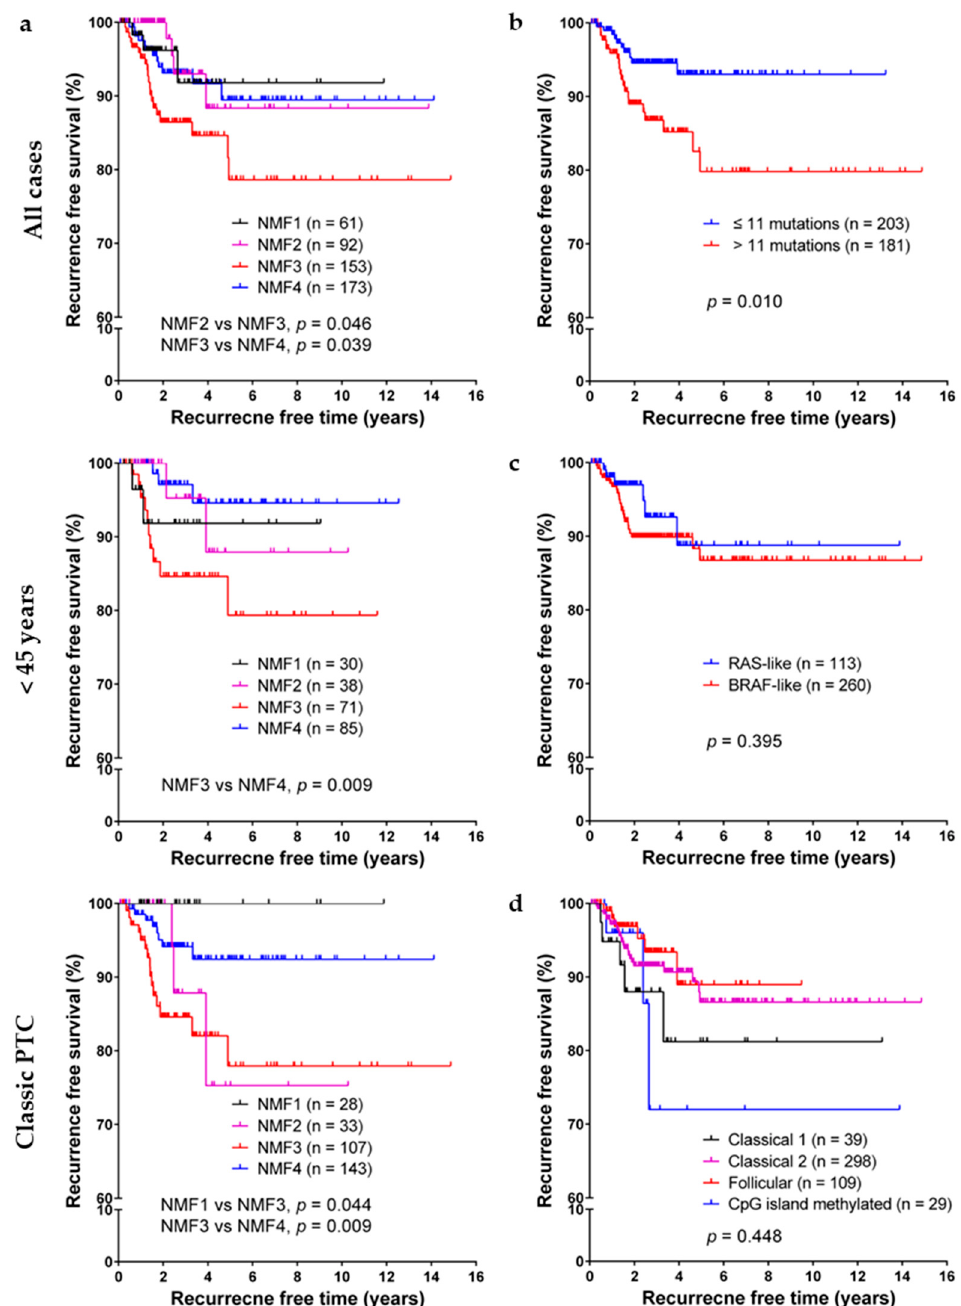
Figure 4. Survival analysis. ( a ) Kaplan–Meier survival curves of papillary thyroid carcinoma (PTC) patients on disease recurrence free survival stratified according to the four NMF clusters; ( b ) Burden of nonsynonymous mutations; ( c ) RAS-BRAF PTC classes; and ( d ) DNA methylation clusters.